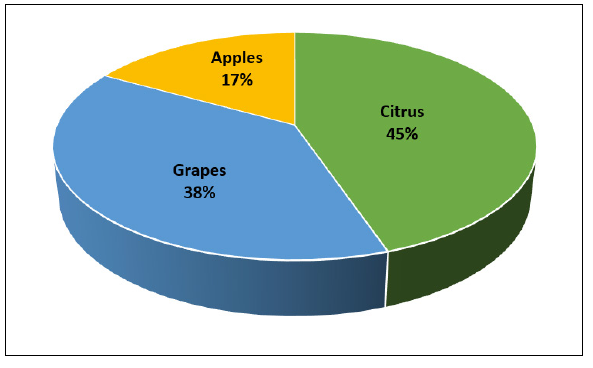
Primary fruit produced in South